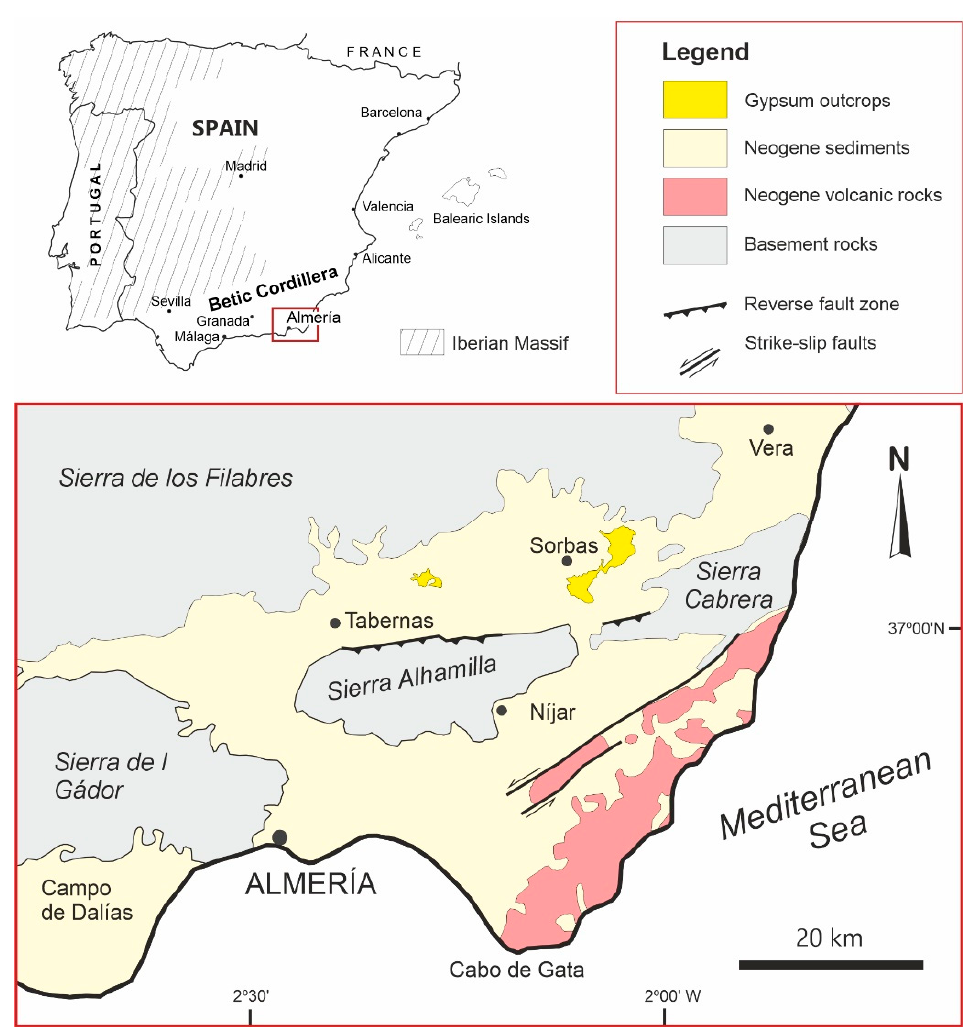
Figure 1. Location of Tabernas–Sorbas Basin. The Messinian gypsum are indicated in yellow (modified from Do Couto et al., 2014 [21]).